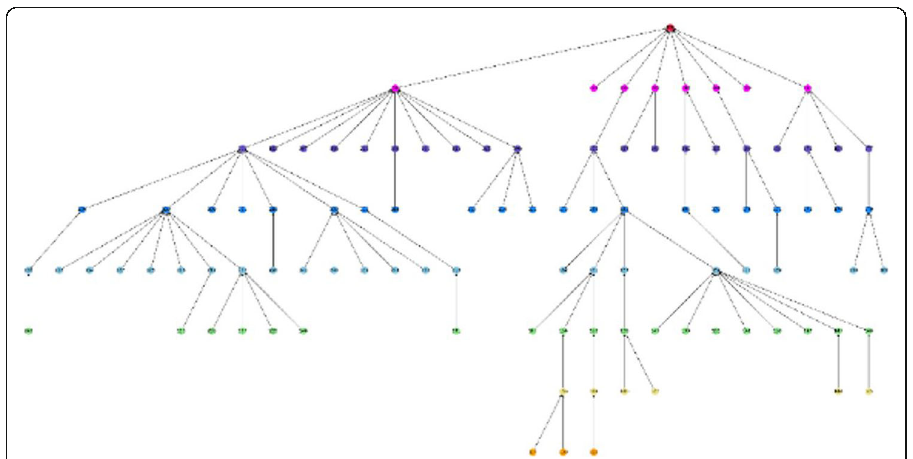
Fig. 3 DODAG with 100 nodes. Example of a Destination-Oriented Directed Acyclic Graph (DODAGs) with 100